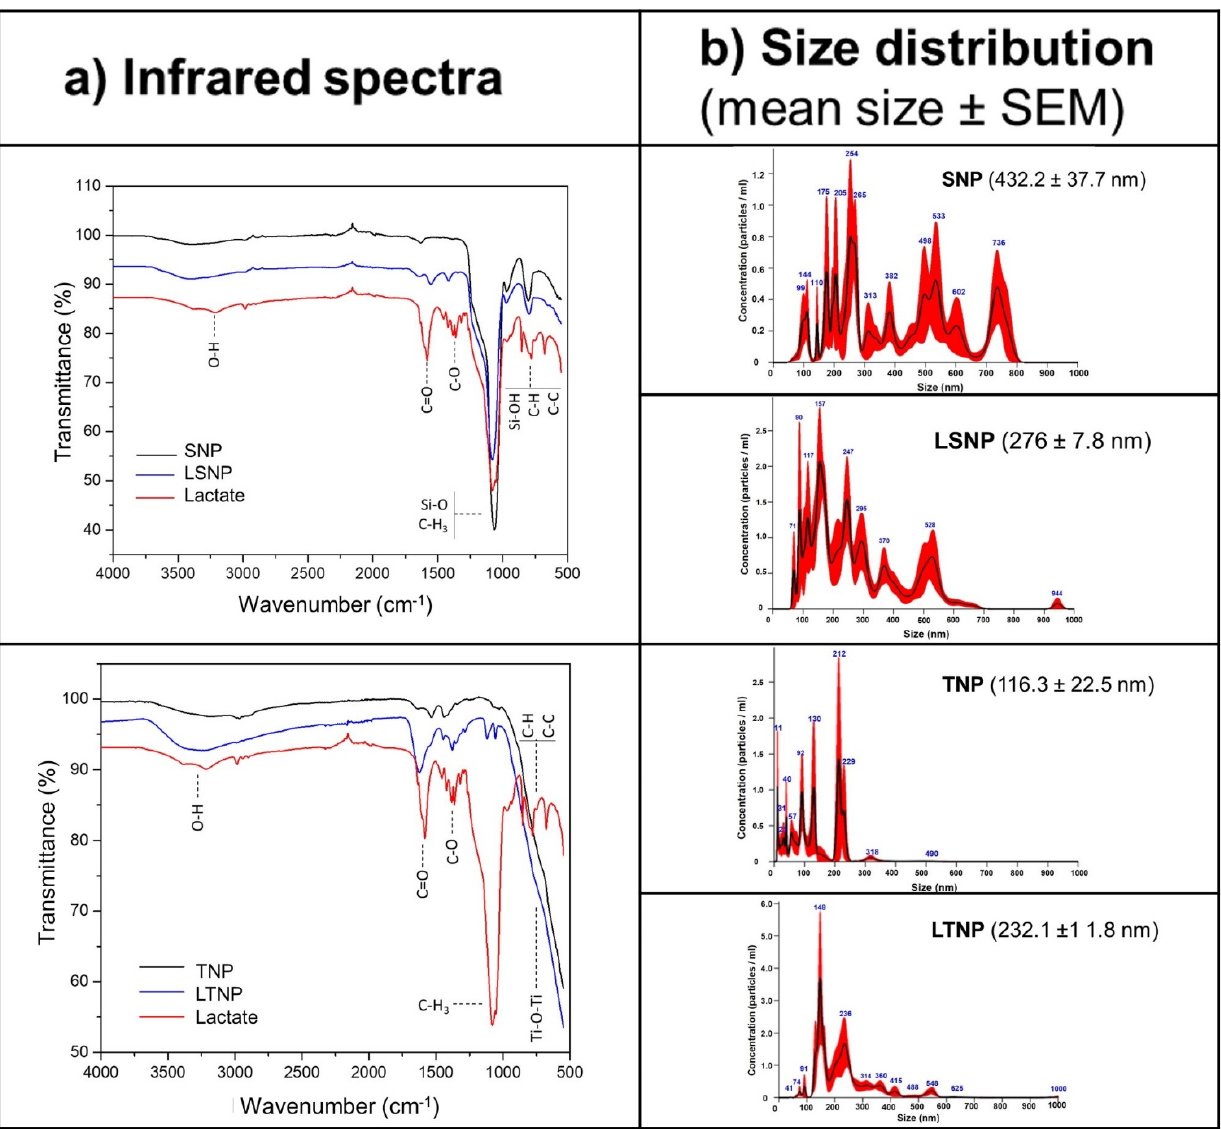
Figure 1. Silica and titania nanoparticles were efficiently loaded with lactate. ( a ) Five mg of each (dry weight) of the nanoparticles were analyzed on a spectrophotometer with an ATR detector, obtaining the infrared spectra of the silica nanoparticles (SNP-black line) and the lactate-loaded silica nanoparticles (LSNP-blue line) compared with the lactate spectrum (red line) (upper left panel), and the infrared spectra of the titania nanoparticles (TNP-black line) and the lactate-loaded titania nanoparticles (LTNP-blue line) compared with the lactate spectrum (red line) (lower left panel). ( b ) Nanoparticles were suspended in PBS at 250 µg/mL and analyzed with the red laser module (532 nm) of the Malvern Nanosight NS300 instrument. Histograms show mean particle size distribution, the black line represents mean size, and red bars show ±1 SEM.